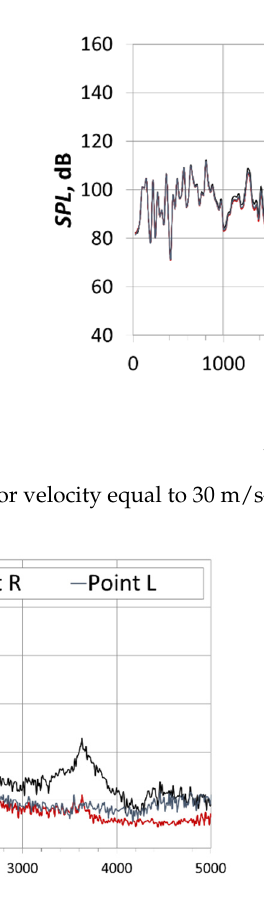
Figure 8. Spectral analysis of SPL for velocity equal to 30 m/s—experimental data.